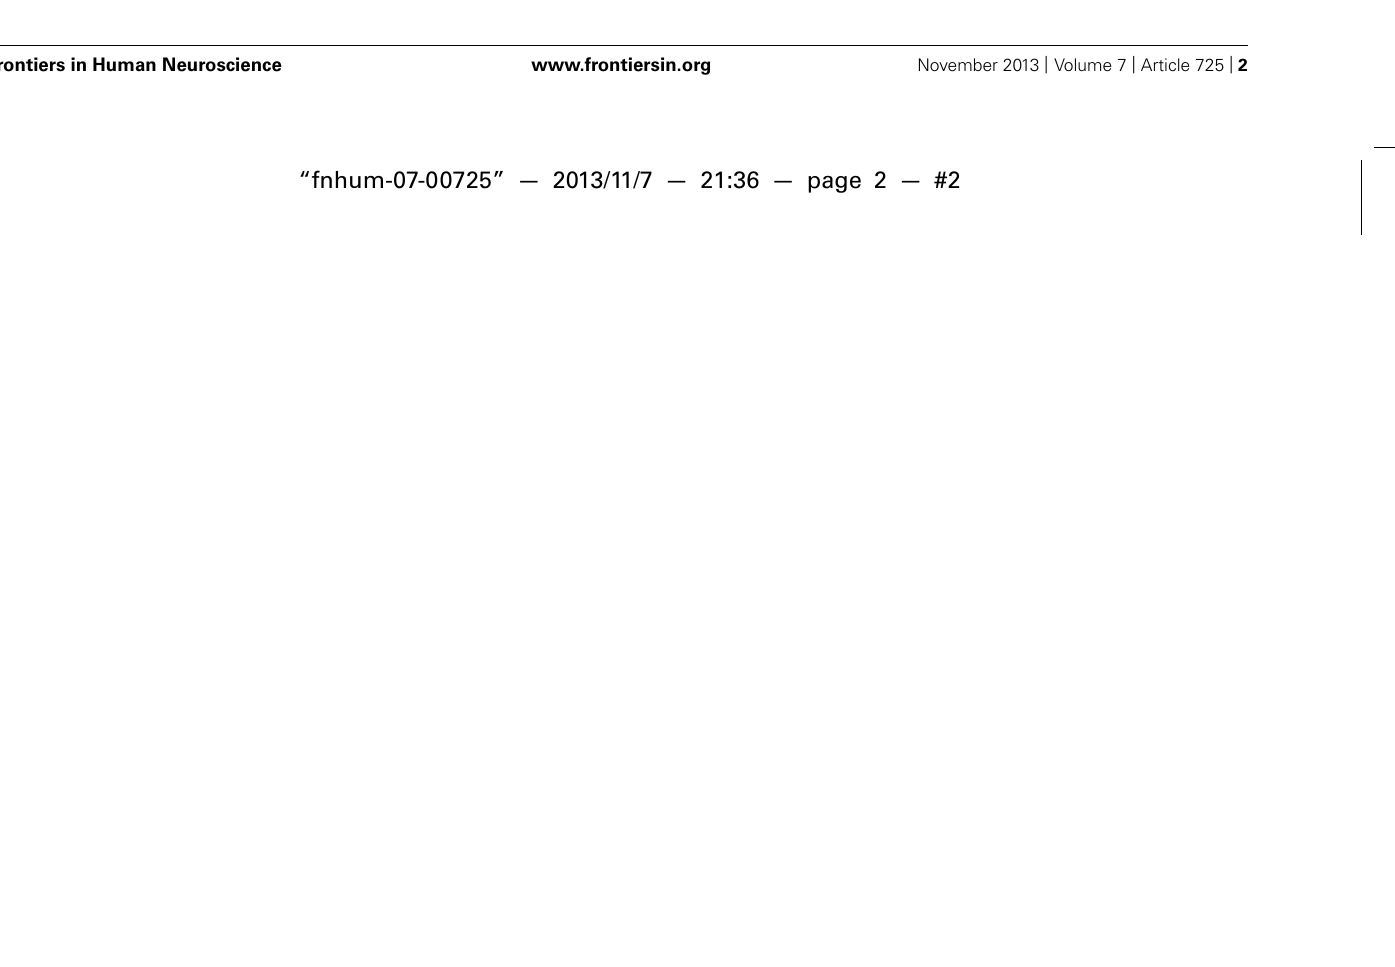
FIGURE 1 | Brain-model of action perception circuits (APCs) and semantic mechanisms. (A) Based on corticocortical connections and correlated activity patterns in primary motor and auditory areas (M1, A1), APCs develop for spoken word forms; these include neurons in primary areas and in “relay areas” bridging between them [inferior PM (premotor) and PF (prefrontal); superior-temporal AB (auditory belt) and PB (parabelt)]. (B) Object-related and action-related semantic information is bound to word